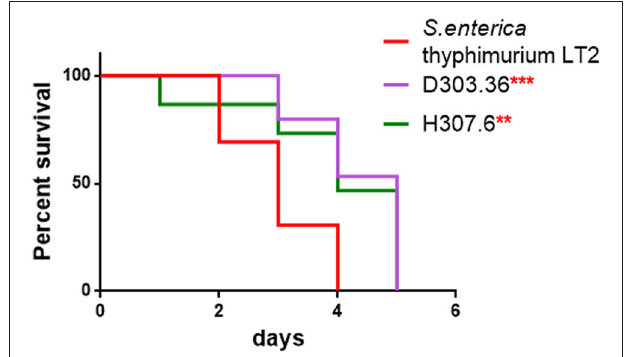
FIGURE 4 | Rescuing potential of L. pentosus D303.36 and L. coryniformis H307.6 against Salmonella enterica infection. Kaplan–Mèier Survival plot of C. elegans fed L. pentosus D303.36 or L. coryniformis H307.6 in a 1:1 co-colture with S. enterica serovar Thyphimurium LT2. Worms fed Salmonella alone were taken as control (** p < 0.01; *** p < 0.001).